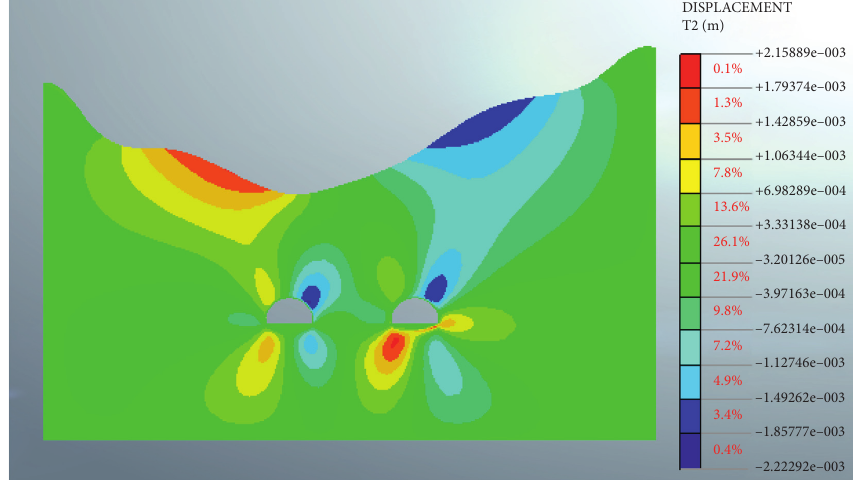
Figure 14: Horizontal displacement distribution of surrounding rocks in double-side guide pit method.